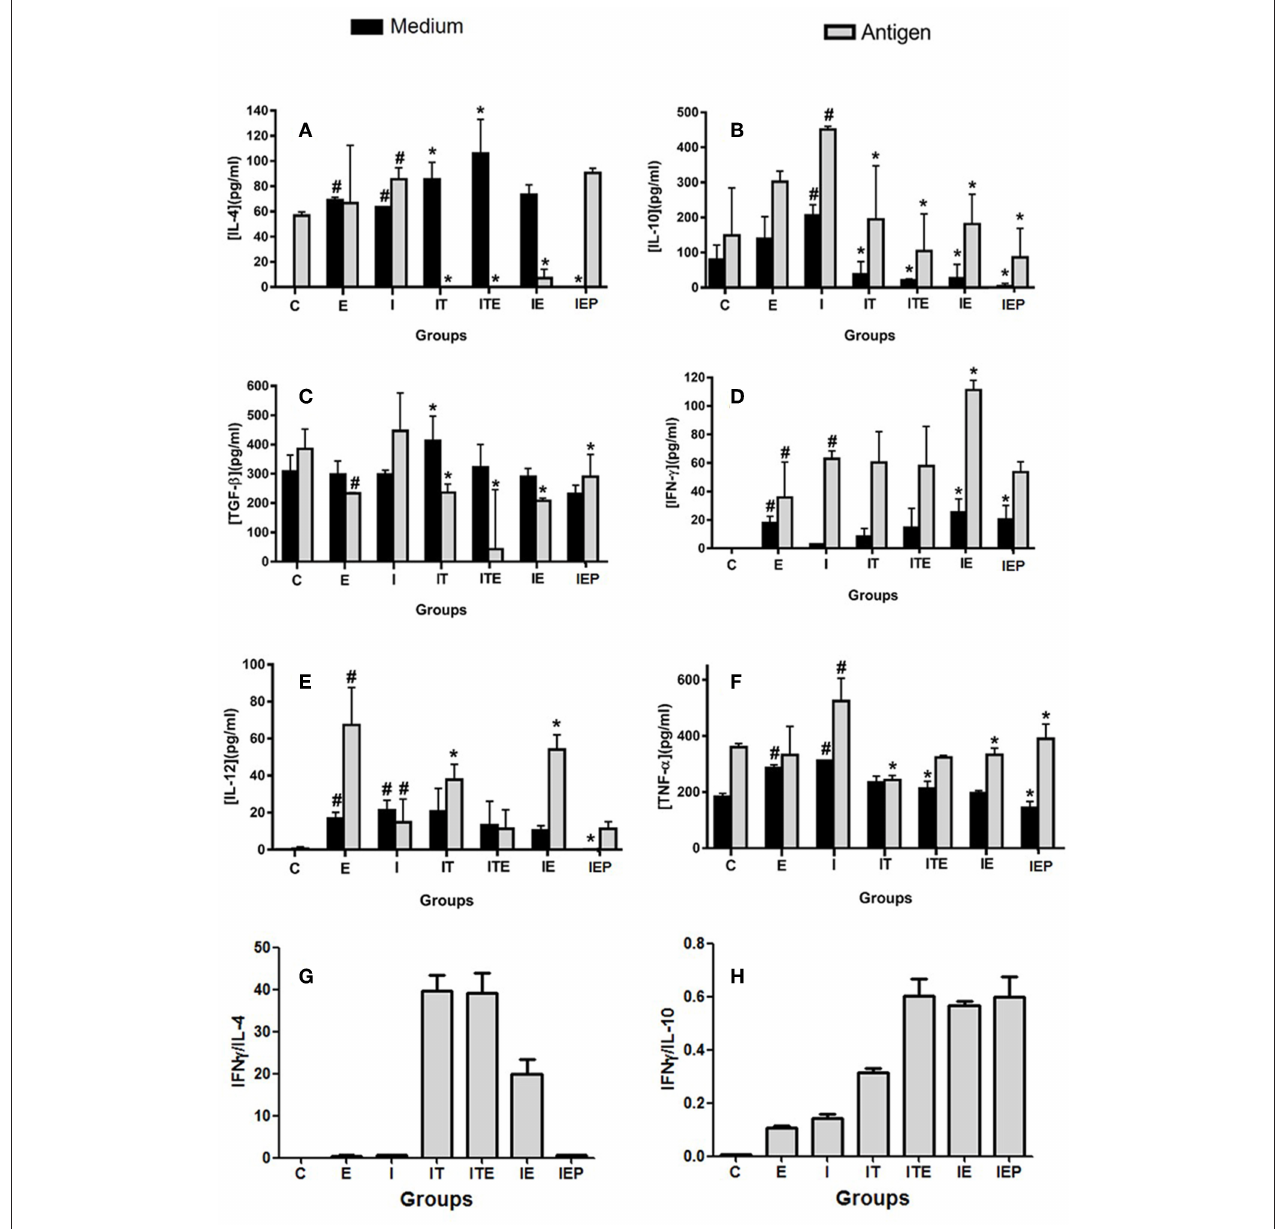
FIGURE 5 | Effect of physical exercise on cytokine production by lymph node cells of BALB/c mice. The concentration of cytokines was determined by ELISA according to Material and Methods. Values represent the mean of two experiments with samples of the eight animals per group grouped as a pool. (A) IL-4; (B) IL-10; (C) TGF- β ; (D) IFN- γ ; (E) IL-12; (F) TNF- α ; (G) IFN- γ /IL-4 ratio; (H) IFN- γ /IL-10 ratio. The bars represent the standard error. C—Sedentary and uninfected. E—Trained not infected. I—Infected. IT—Animals infected and treated with a therapeutic dose (8 mg) of Glucantime ® , after the onset of the lesion. ITE—Animals infected, trained and treated with therapeutic dose (8 mg) of Glucantime ® after the onset of injury. IE—Animals infected and trained from the first week of infection. IEP—Animals infected and trained after the appearance of the lesion (6th week). #P < 0.05 in relation to C and in * P < 0.05 in relation to